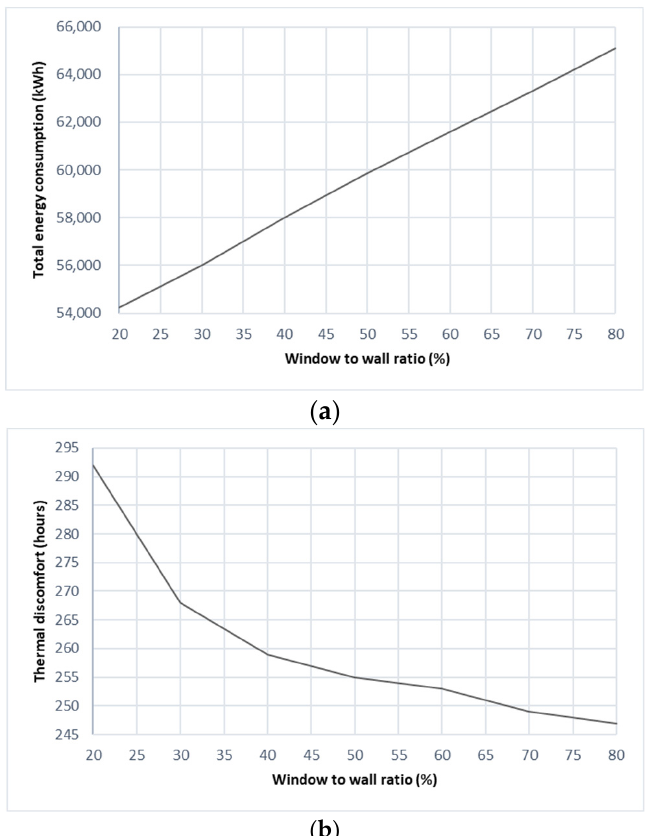
Figure 10. The effect of window to wall ratio on ( a ) energy consumption and ( b ) students’ thermal discomfort hours.